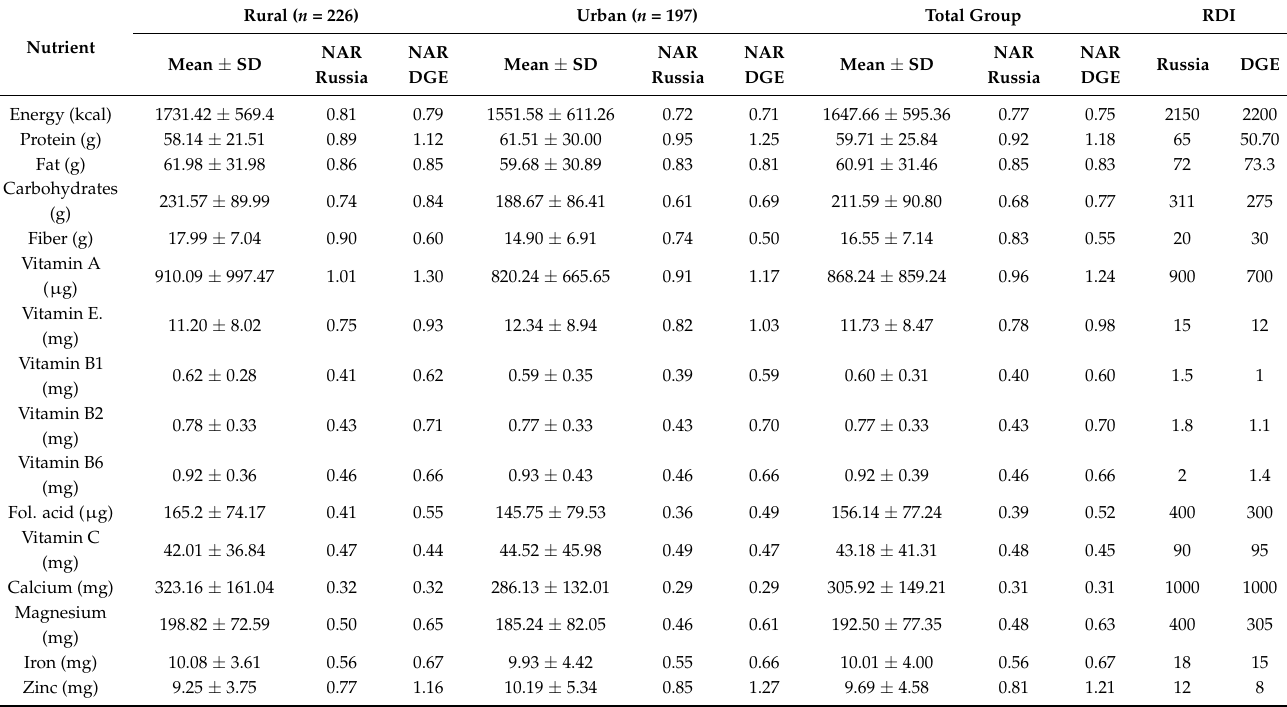
Table 4. Nutrient intake and its adequacy measured by 24-hour diet recall ( n =